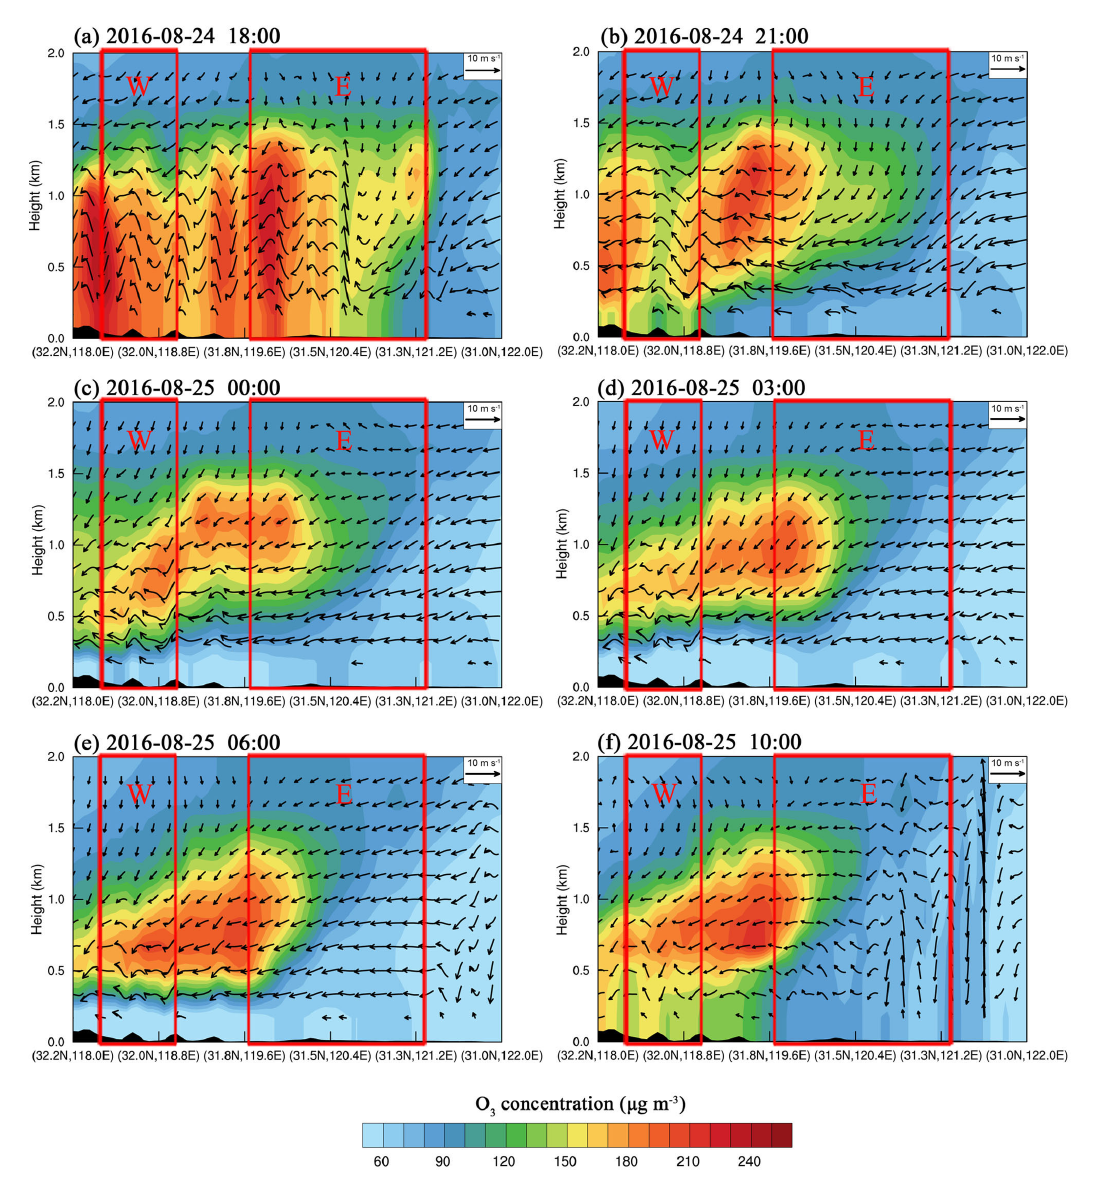
Figure 6. Vertical sections of O 3 concentrations (contours) and atmospheric circulation (wind vectors) along the regional O 3 transport route (red solid line in Fig. 1b) from east to west over the YRD region. The W and E box columns mark the western YRD area surrounding NJ and the eastern YRD area covering CZ, WX, SZ and SH, respectively, from 24 to 25 August 2016. The vertical wind velocities are multiplied by 50 for the illustration of vertical